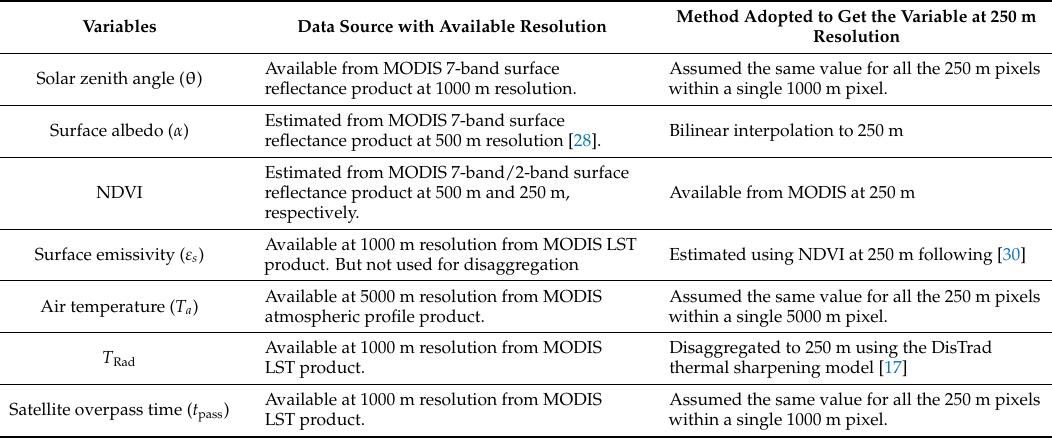
Table 1. Getting the input variables for estimating ( R n − G ) day at 250 m